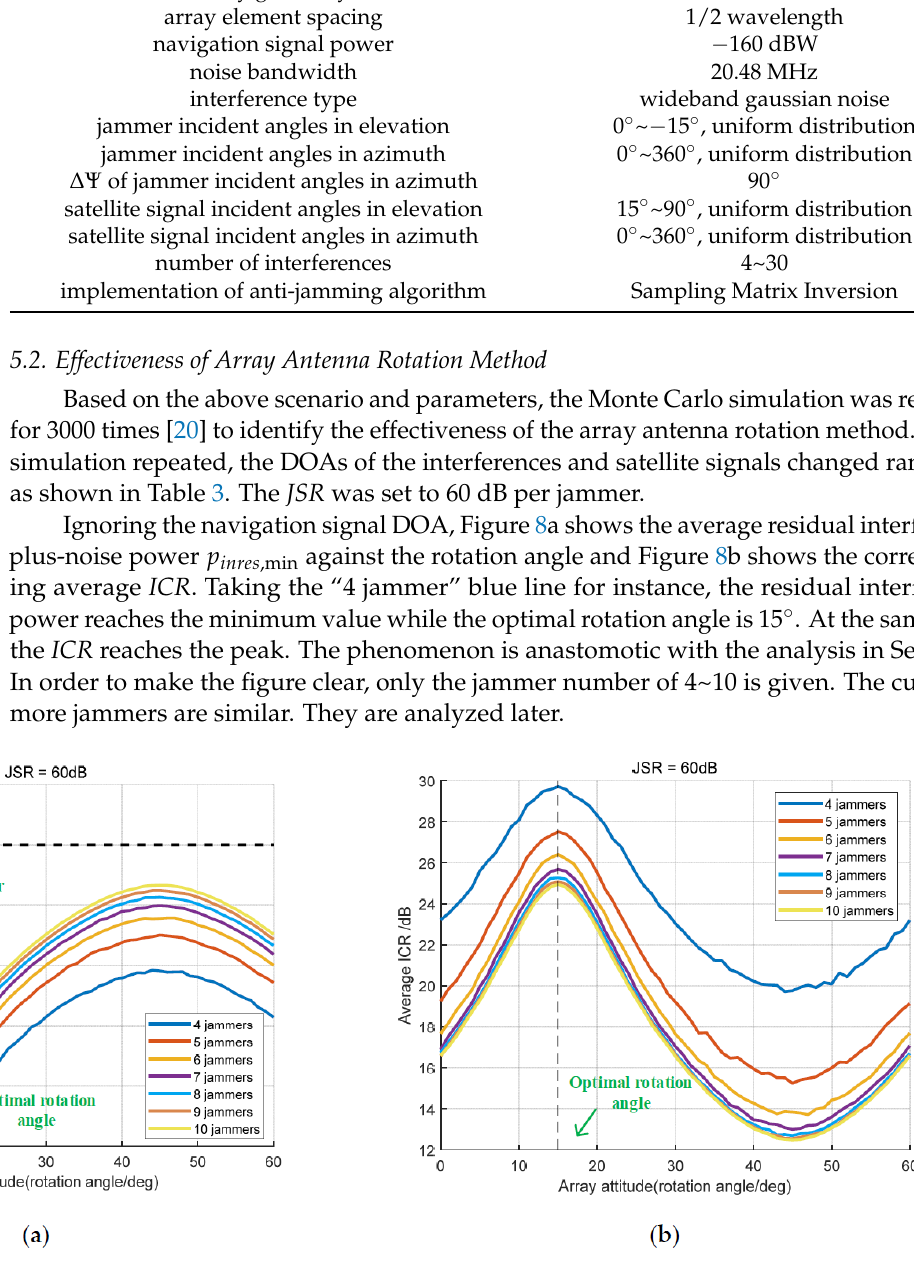
Figure 8. Simulation results ignoring navigation signal DOA. ( a ) Residual interference-plus-noise power against rotation angle. ( b ) ICR against rotation